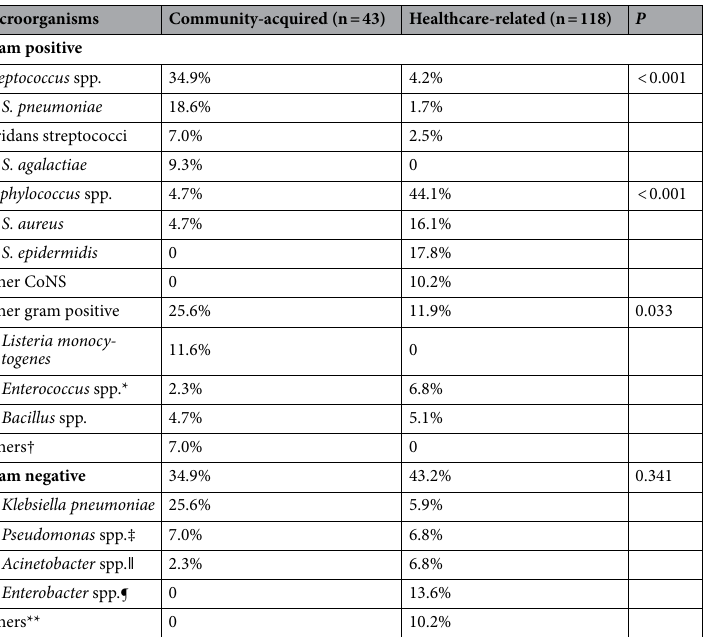
Table 3. Causative microorganisms. Abbreviations: CoNS, Coagulase-negative staphylococci. * E. faecalis (n = 5) and E. faecium (n = 4). † Corynebacterium species, Micrococcus species, and Parvimonas micra (n = 1 for all). ‡ P. aeruginosa (n = 10) and P. fluorescens (n = 1). ∥ A. baumannii (n = 7) and A. lwoffii (n = 2). ¶ E. aerogenes (n = 13) and E. cloacae (n = 3). ** Serratia marcescenes (n = 4), Stenotrophomonas maltophilia (n = 3), Haemophilus influenzae (n = 2), Escherichia coli (n = 1), Morganella morganii (n = 1), and Moraxella species (n =